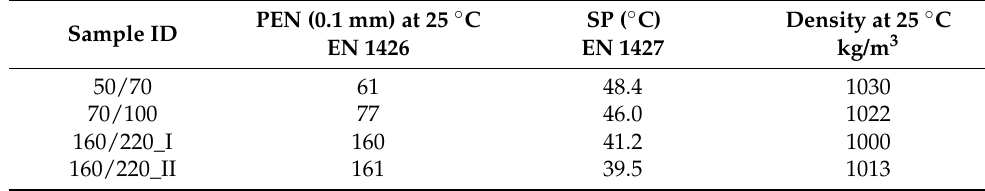
Table 1. Bitumen type and